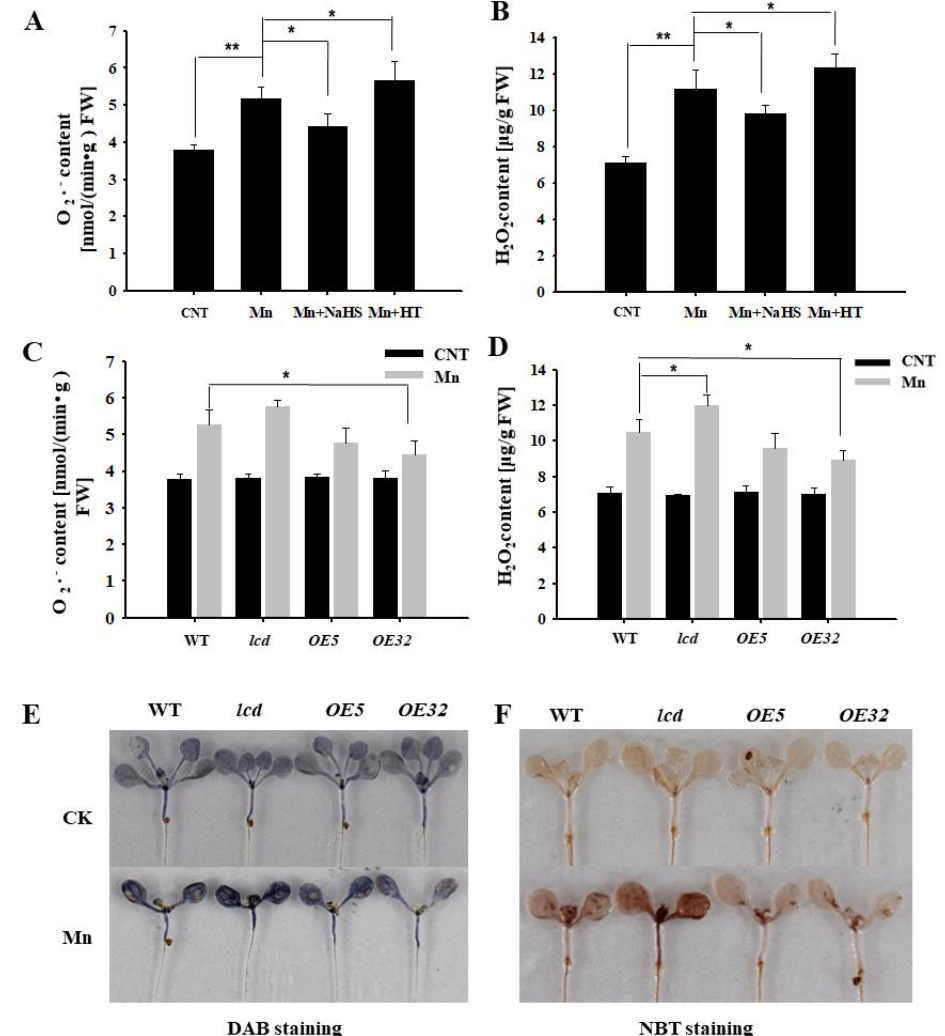
Figure 5. Effects of H 2 S on H 2 O 2 and O 2 − contents in Arabidopsis seedlings under Mn stress. Effects of NaHS and HT on the quantitative measurement of O 2 − ( A ) and H 2 O 2 ( B ) concentrations in wild-type Arabidopsis seedlings under Mn stress. Quantitative measurement of O 2 − ( C ) and H 2 O 2 ( D ) concentrations in wild type, lcd , and two independent overexpression lines seedlings treated with and without manganese. In situ accumulations of H 2 O 2 ( E ) and O 2 − ( F ) before and after Mn treatment were revealed by DAB and NBT staining, respectively. Three independent experimental replications were conducted. Values are the means ± SE of three independent experiments (* p < 0.05; ** p < 0.01).